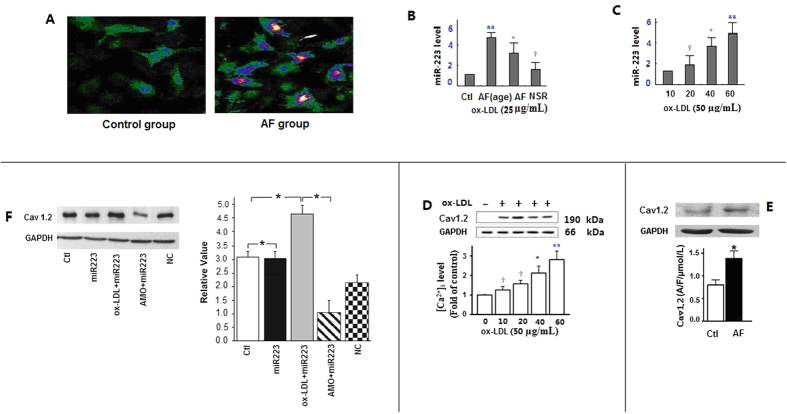
Ox-LDL induces increased of Ca2+ channel protein and miRNA-223 expression.(A) The control group (left) of myocardial cells was not been treated with ox-LDL and does not show lipid constituent based fluorescence with laser scanning confocal microscopy. The AF group (right) showed that in ox-LDL treated myocardial cells, transfection efficiencies >80% were detected by fluorescence microscopy, which are suggestive of increased ox-LDL production by 50 μg/mL ox-LDL for 60 min. (B,C) Enhanced miRNA-223 expression was induced by ox-LDL. A “dose-response” relationship between miRNA-223 and ox-LDL levels was observed. Bars represent mean ± SD of quantitative densitometric analyses from three separate experiments. **P < 0.001 vs. Ctl, *P < 0.01 vs. Ctl, †P < 0.05 vs. Ctl. (D) Effect of enhanced miRNA-223 on ox-LDL-induced [Ca2+]i generation. [Ca2+]i formation was measured with or without ox-LDL treatment for 10, 20, 40, and 60 min. A “dose-response” relationship was observed between Cav1.2 protein and ox-LDL levels. Bars represent mean ± SD of quantitative densitometric analyses from four separate experiments, **P < 0.001 vs. Ctl, *P < 0.01 vs. Ctl, †P < 0.05 vs. Ctl. (E) Cav1.2 protein expression was measured at 30 min after 25 μg/mL ox-LDL treatment or without ox-LDL treatment. *P < 0.01 vs. Ctl. (F) Left, verification of Cav1.2 protein expression changes by western blotting. Right, Cav1.2 expression changes were higher in Tg mice exposed to ox-LDL than in NC mice, *P < 0.001. Ctl, mock-treated with ox-LDL; AMO, antisense oligonucleotides against miR-223; NC, negative control.